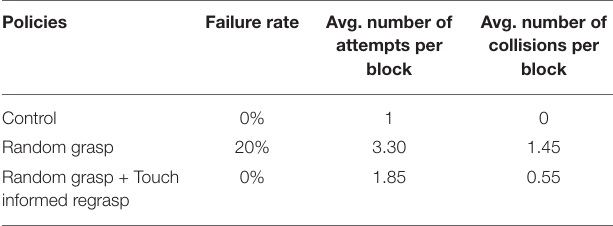
Frontiers in Robotics and AI |